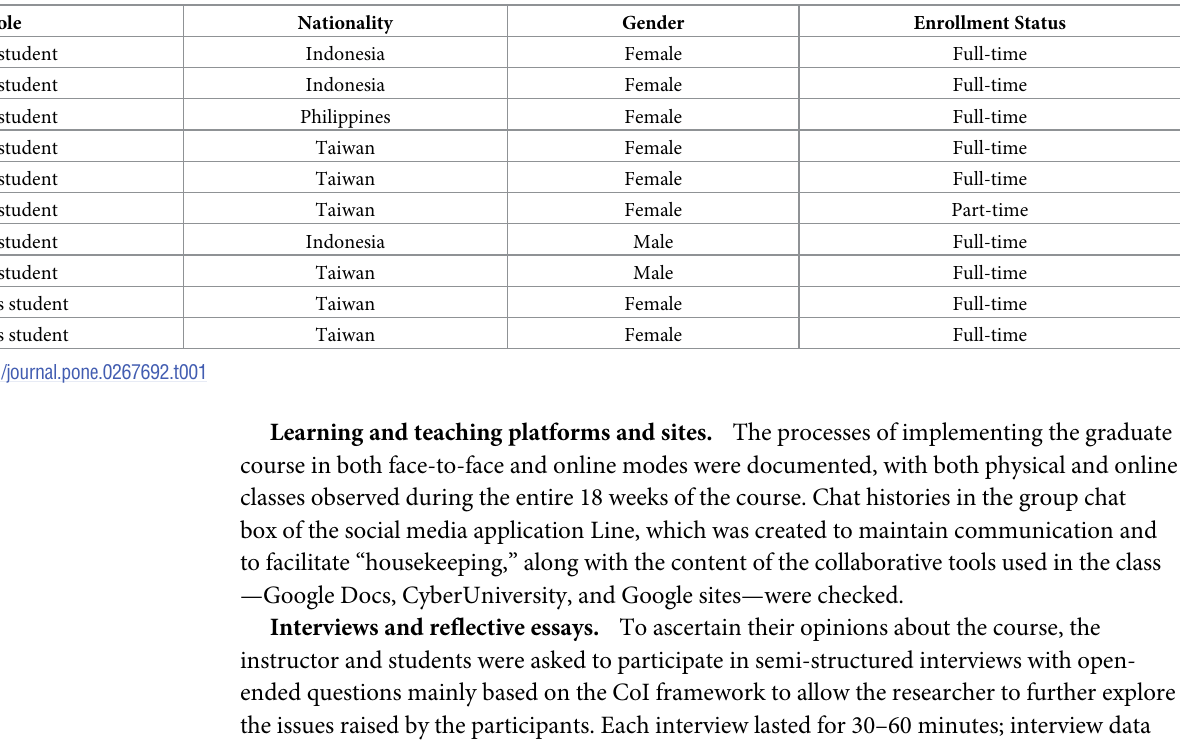
Table 1. Profile of the student